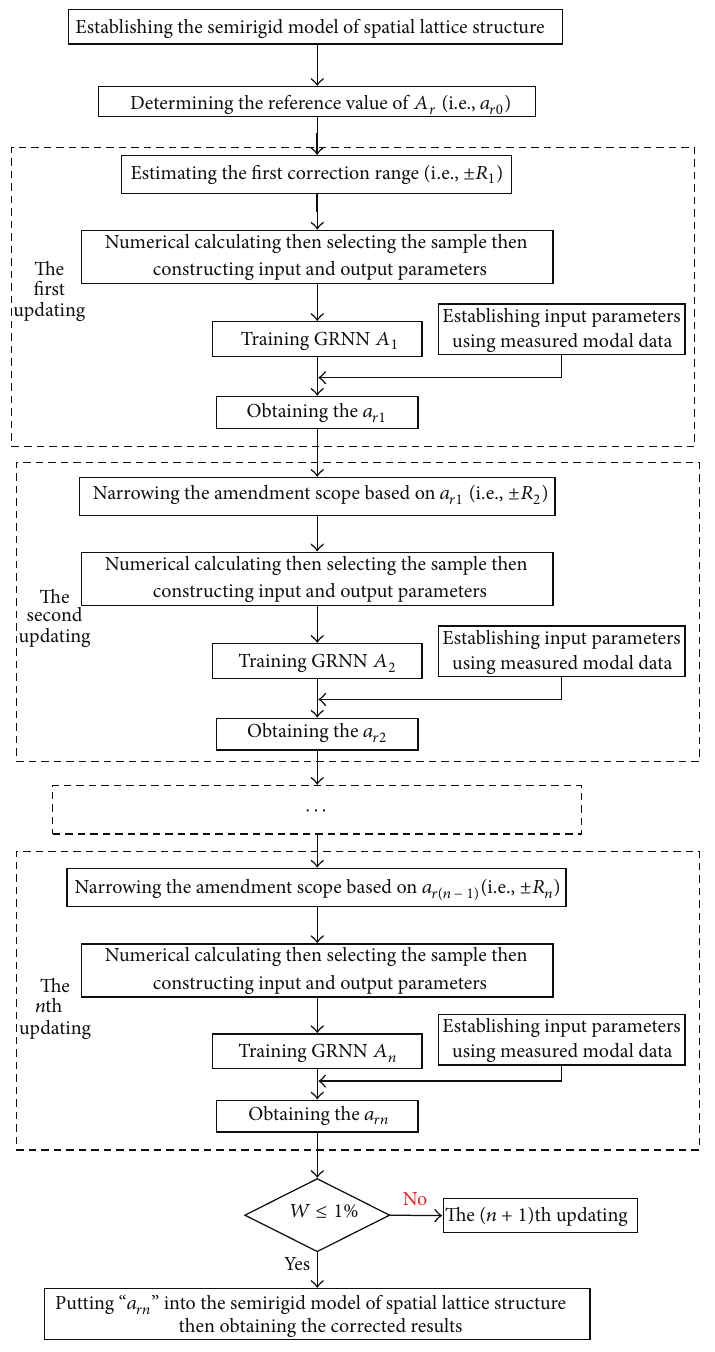
Figure 4: Flowchart of the finite element model fractional steps updating strategy.